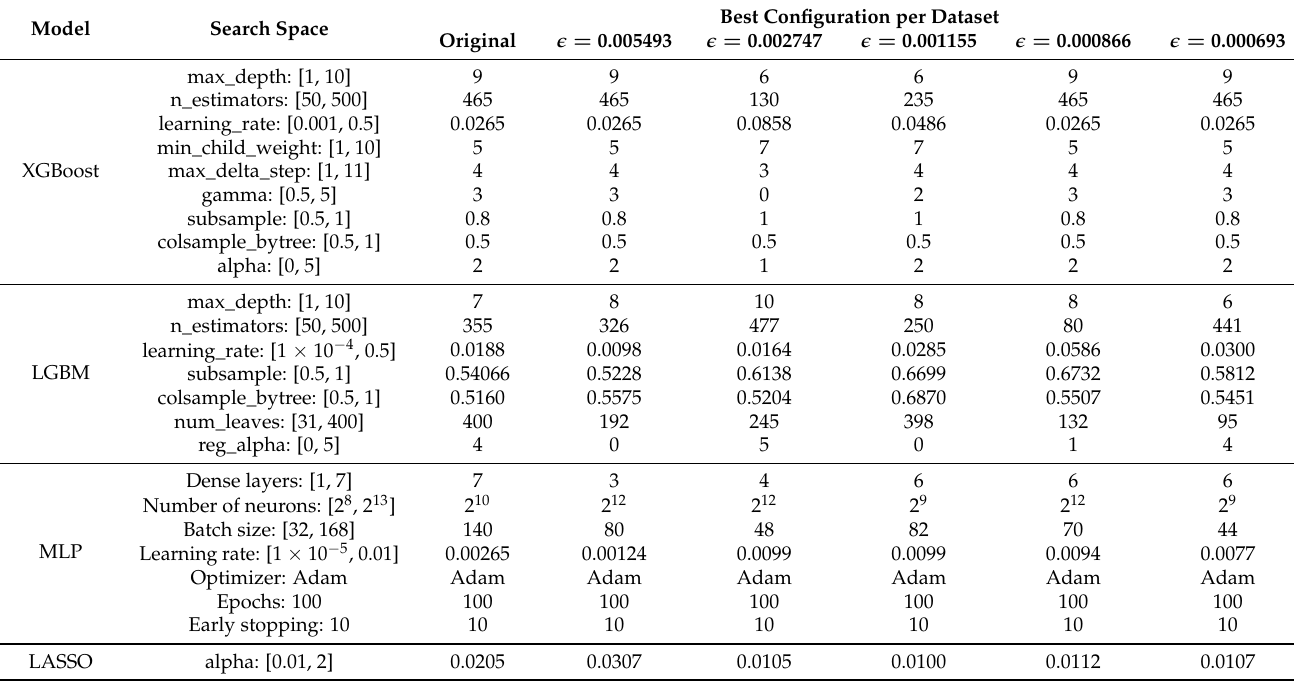
Table A1. Search space for hyperparameters by ML model and the best configuration obtained for predicting ARTs per dataset.